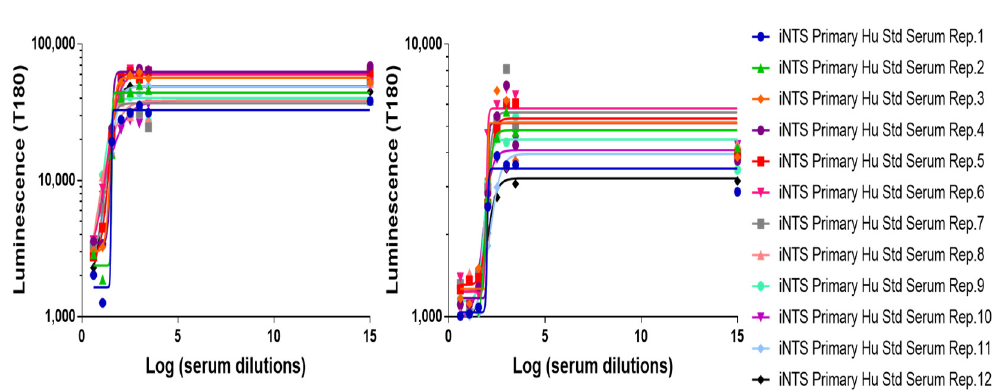
Figure 3. Luminescence vs. log of serum dilution of samples tested to assess LoD and LoQ . Symbols represent single measurements. Solid lines represent the fitted four-parameter curves to single- measurement data for each sample assayed against the two Salmonella strains, S. Typhimurium D23580 and S. Enteritidis CMCC4314. Table 1. LoD and LoQ , expressed as IC50, for each of the two Salmonella strains tested, S . Typhimurium D23580 and S . Enteritidis